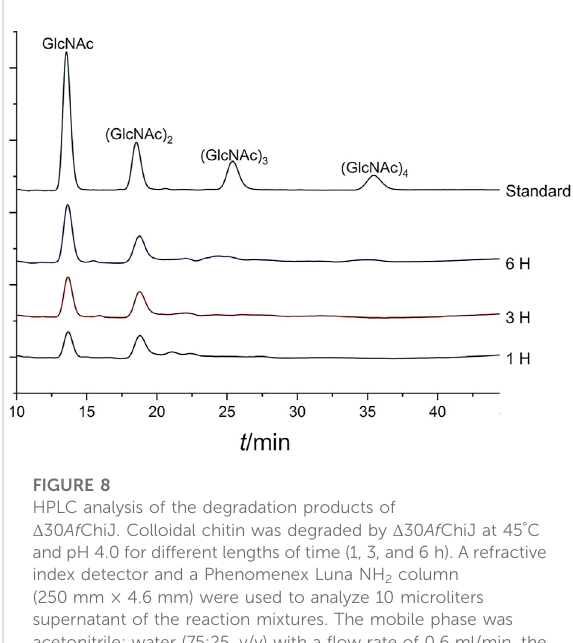
FIGURE 8 HPLC analysis of the degradation products of Δ 30 Af ChiJ. Colloidal chitin was degraded by Δ 30 Af ChiJ at 45 ° C and pH 4.0 for different lengths of time (1, 3, and 6 h). A refractive index detector and a Phenomenex Luna NH 2 column (250 mm × 4.6 mm) were used to analyze 10 microliters supernatant of the reaction mixtures. The mobile phase